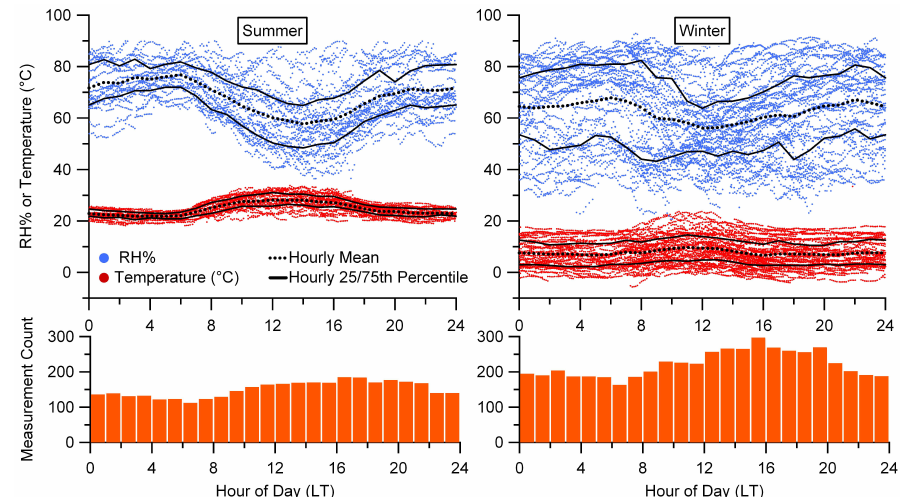
Fig. 3. Diurnal temperature, RH and measurement frequency. Each colored point in the RH and temperature plots is the average value during a single EF, DF or Drying process measurement. A point exists for every measurement during each study. The cessation of operation beyond certain RH and temperature limits discussed at the end of Sect. 2.2 produces corresponding artifacts, e.g. few RH points above 90%. The bottom charts show the diurnal measurement frequency, counting each size distribution